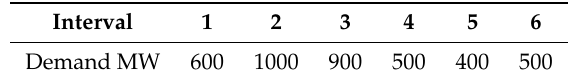
Table 12. Load demand for each scheduling interval of 4 hours